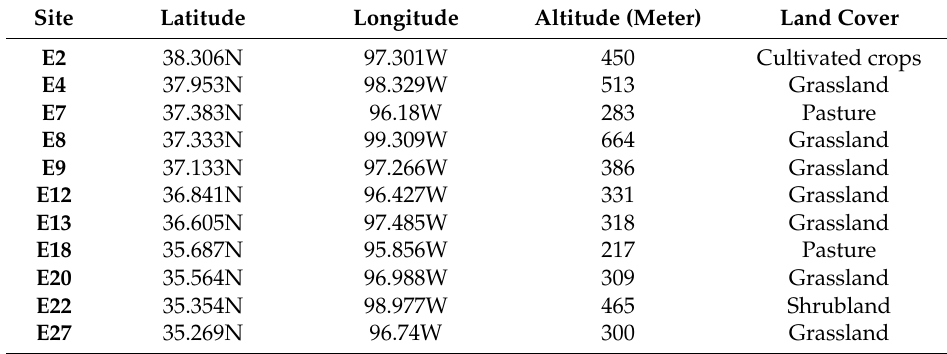
Table 2. Location, altitude and land cover of study